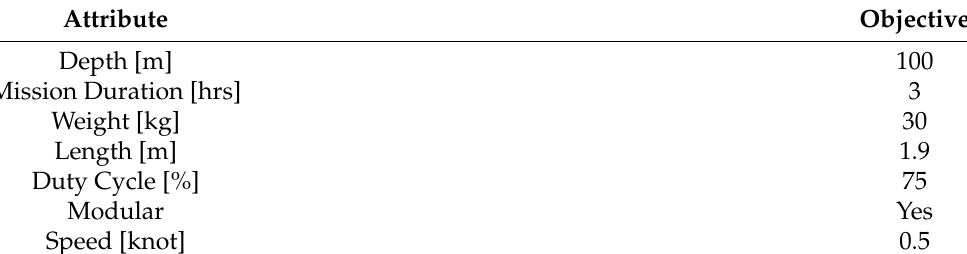
Figure 2. RoboFish’s Mapping of Top-level Design Parameters to KPAs. Table 1. RoboFish Key Performance Attributes